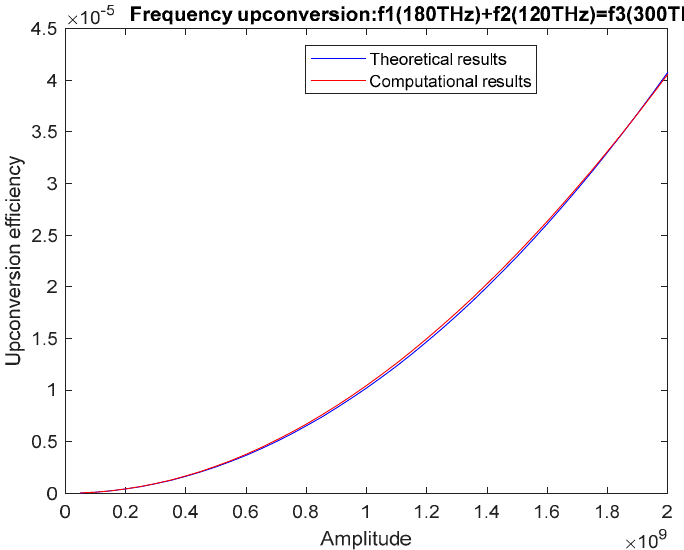
Figure A2. Comparison of the frequency up-conversion e ffi ciencies for f 3 = 300 THz and d = 6.3 × 10 − 22 , versus the pump wave amplitude.